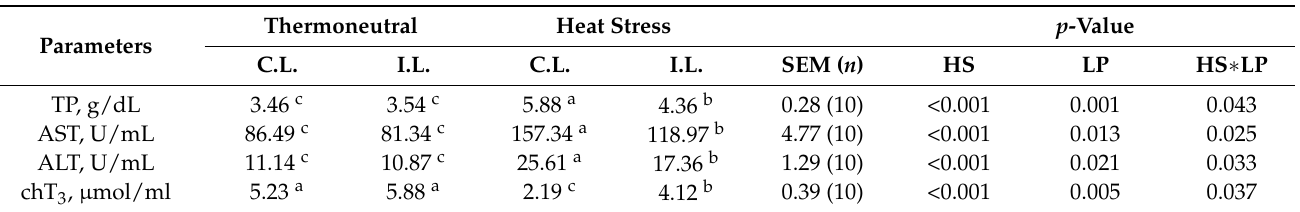
Table 4. Effect of heat stress (HS), light program (LP), and their interaction (HS ∗ LP) on blood metabolites of broiler chicks.